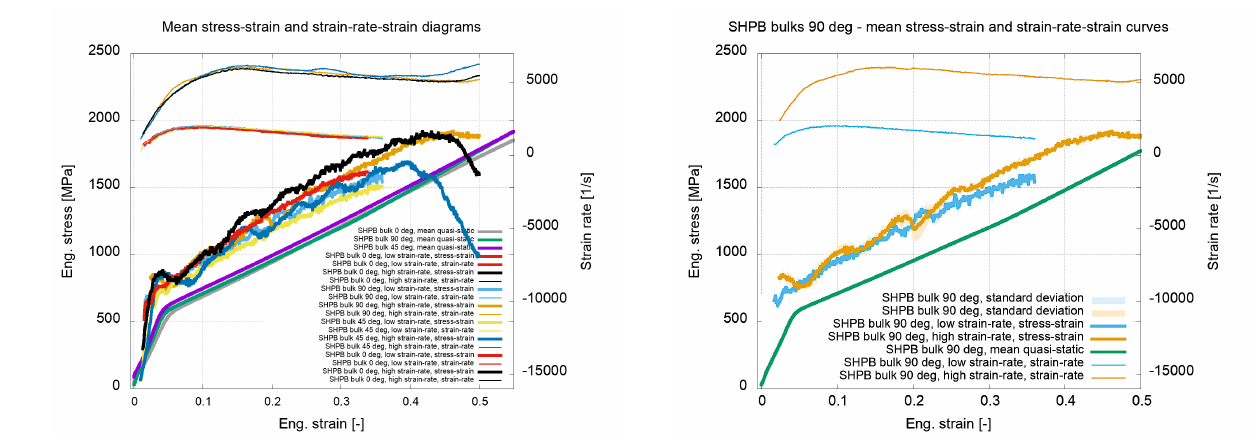
Figure 9. Mean results for the specimens printed at the angle of 90°